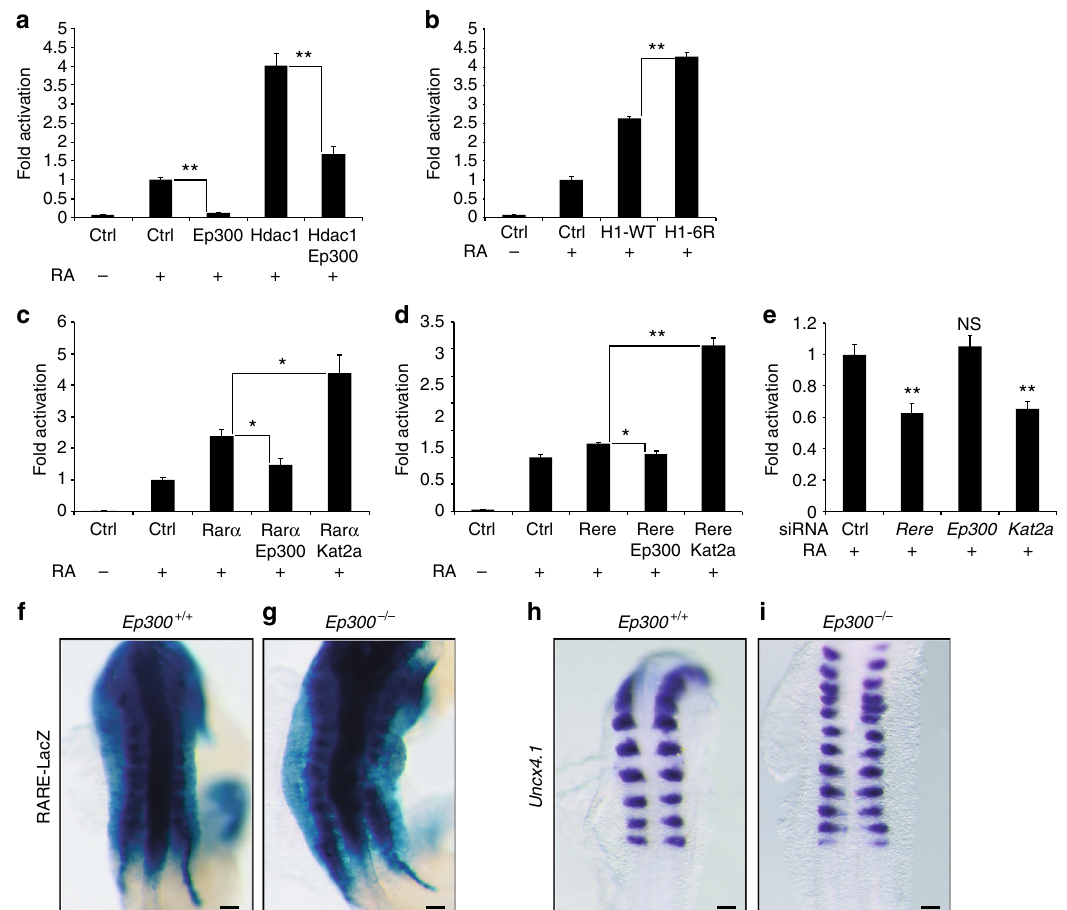
Fig. 7 Kat2a but not Ep300 acts as a coactivator for retinoic acid signaling. a – e RARE-Luciferase activity from NIH3T3 cells treated or not with 1 µ M RA for 20 h. a Cells transfected with expression plasmids containing Ep300 , Hdac1 , or both ( n = 4). b Cells transfected with expression plasmids containing human Hdac1 (H1-WT) or Hdac1 mutant (H1-6R) ( n = 4). c Cells transfected with expression plasmids containing Rar α , Rar α , and Ep300 or Rar α and Kat2a ( n = 3). d Cells transfected with expression plasmids containing Rere , Rere and Ep300 or Rere and Kat2a ( n = 3). e Cells treated either with siRNA for Rere, Ep300 , or Kat2a ( n = 4). In all graphs data represent mean ± s.e.m. NS — not signi fi cant, * P < 0.05 and ** P < 0.01. Student ’ s unpaired two-tailed t -test. f , g RARE-LacZ expression in wild-type Ep300 + / + f and Ep300 – / – g embryos at E8.75-E9.0 ( dorsal views ). h , i In situ hybridization showing somites labeled with Uncx4.1 in wild-type Ep300 + / + h and Ep300 – / – i embryos at E8.75-E9.0 ( dorsal views ). For each genotype at least 5 – 10 embryos were analyzed. Bar = 100 following target genes: Rere, Wdr5, Hdac1, Hdac2 , Ehmt2 , Ep300 , and Kat2a . For single siRNA experiments 100nM of each siRNA was used for the transfection. In the case of double siRNA transfections 50 nM of each siRNA was used for experiments.